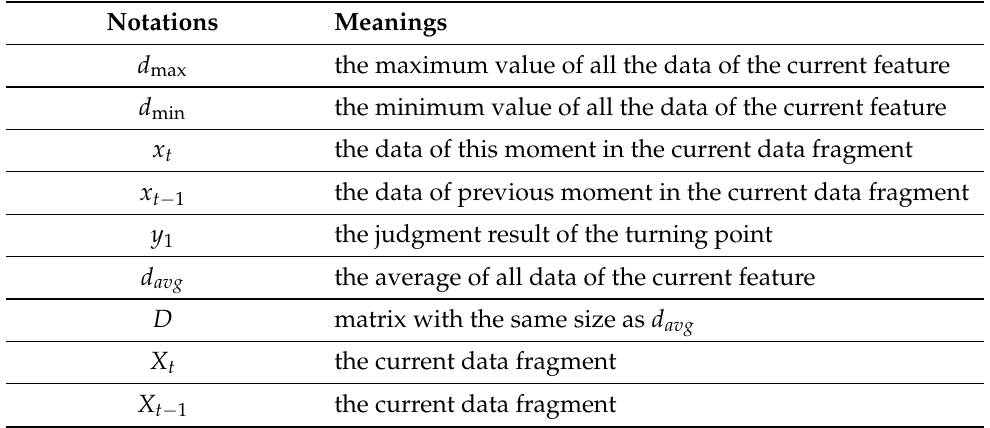
Table 1. Notations and their